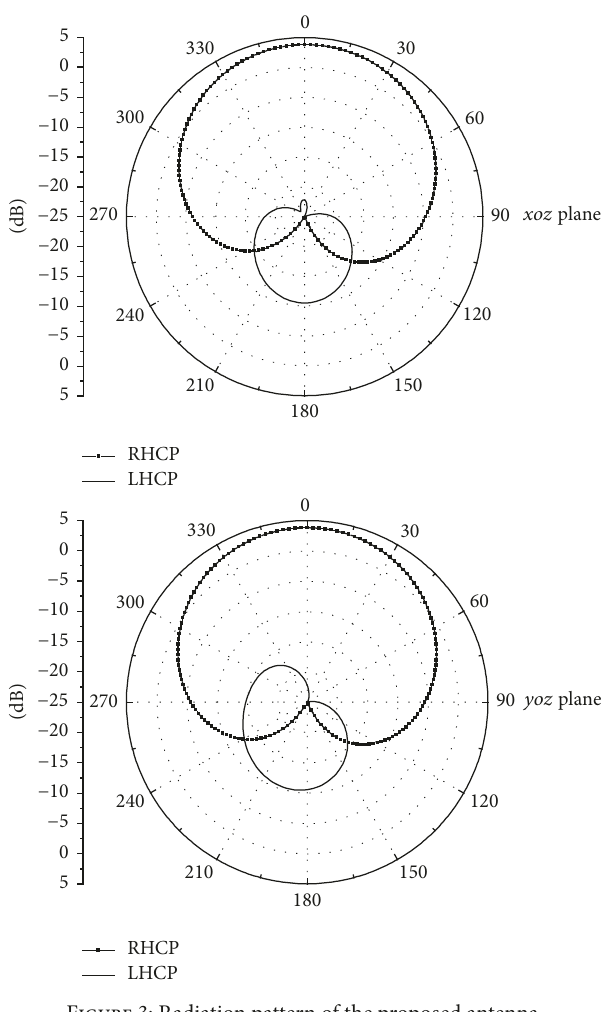
Figure 3: Radiation pattern of the proposed antenna.